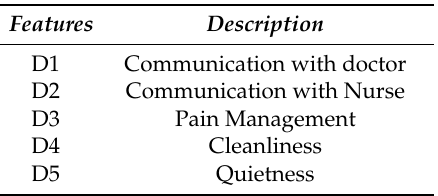
Table 3. Features of Satisfaction Dataset.